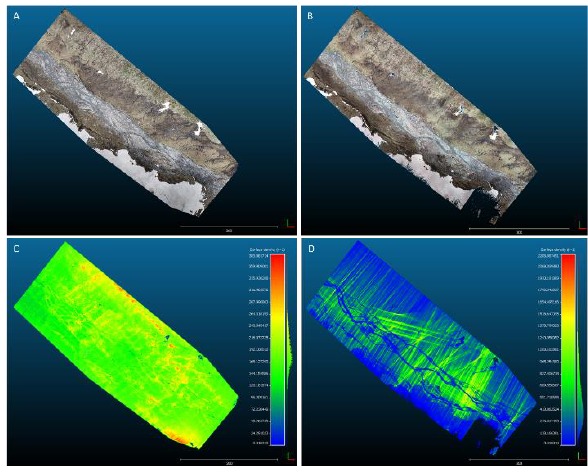
Figure 9. Textured point clouds from photogrammetry (A) and LiDAR (B) with corresponding maps of point density (C,